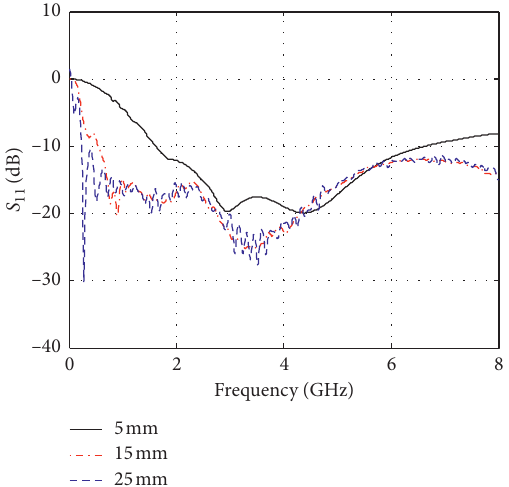
Figure 12: Simulated reflection coefficient of antennas with dif- ferent disc ground radii.